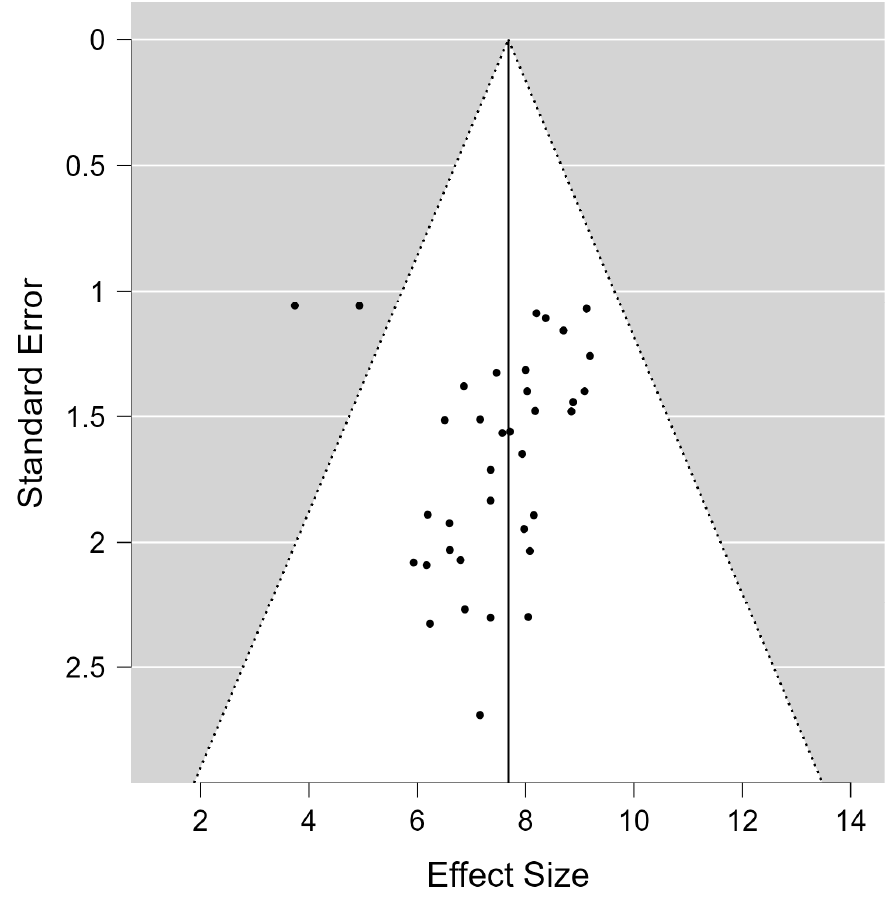
Figure 3. Funnel plot of social subscale.